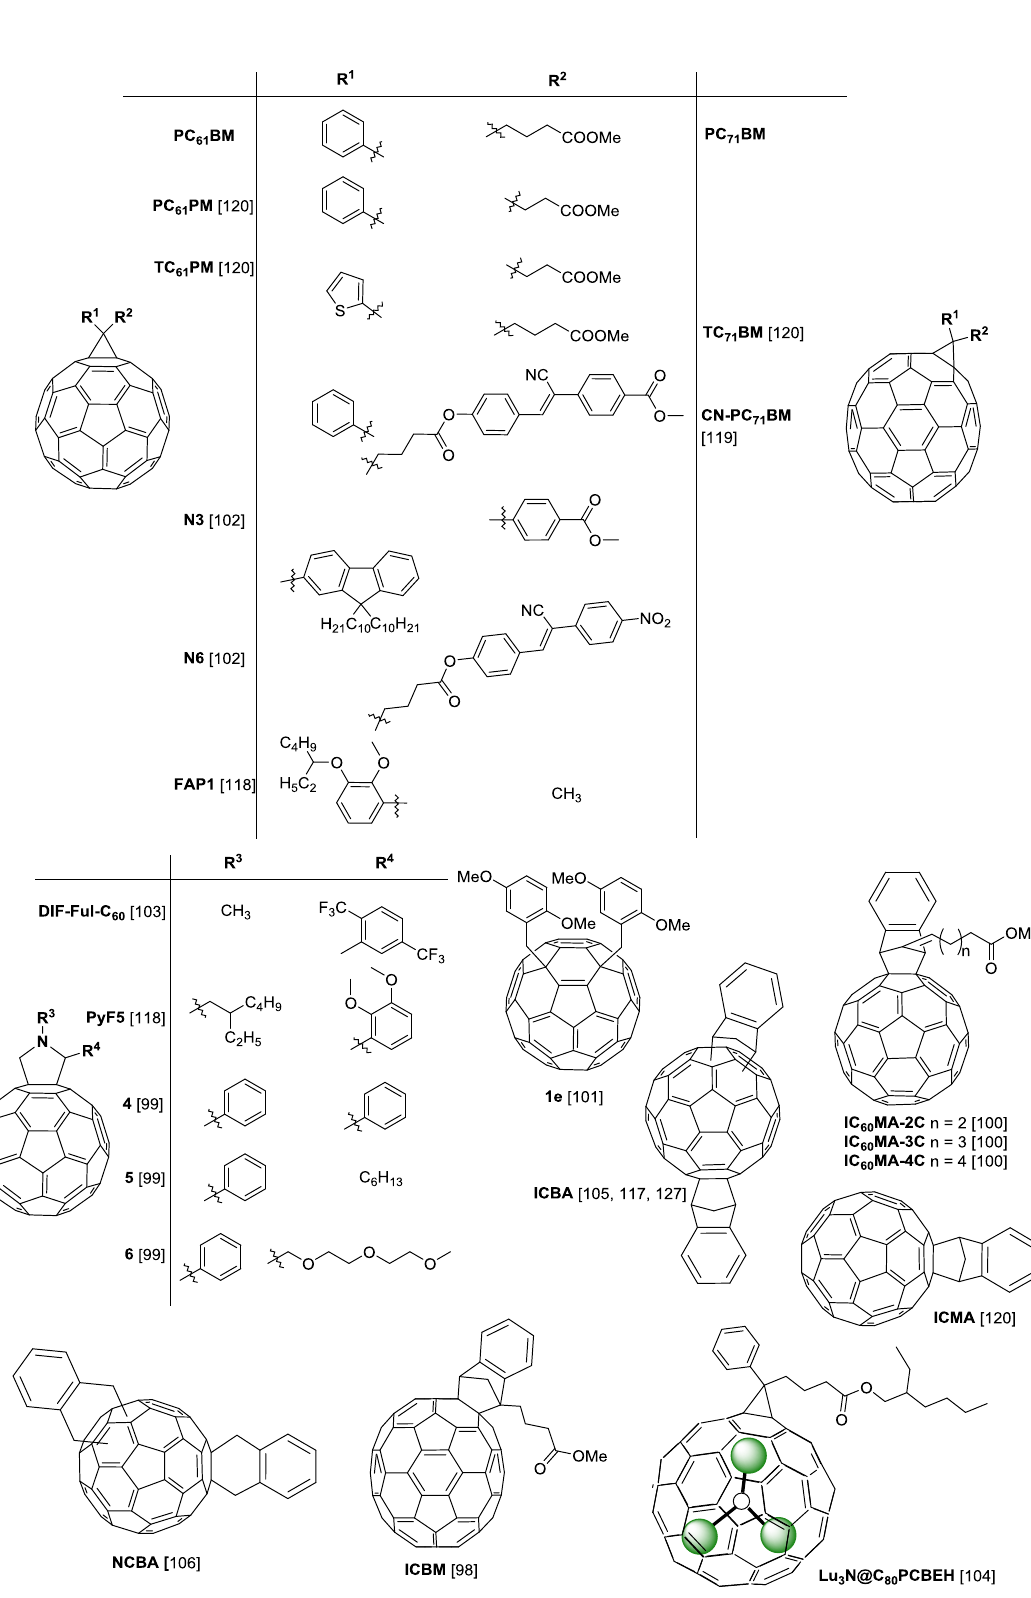
Figure 5. Chemical structures of the fullerene acceptors tested in OPVs in this review.